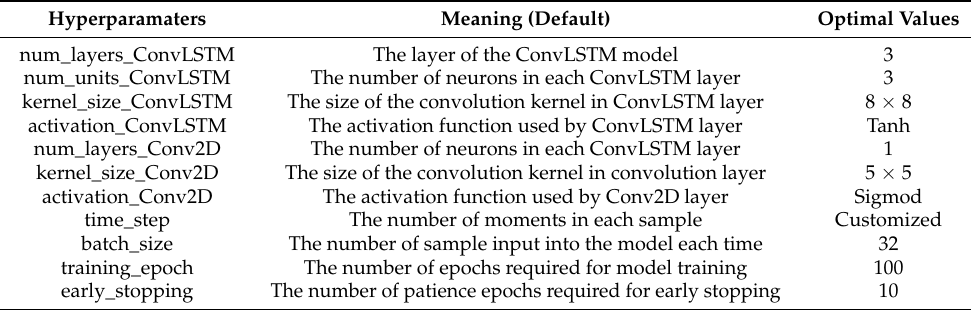
Table 1. Parameters of the ConvLSTM model and optimal values after tuning for ST/SS